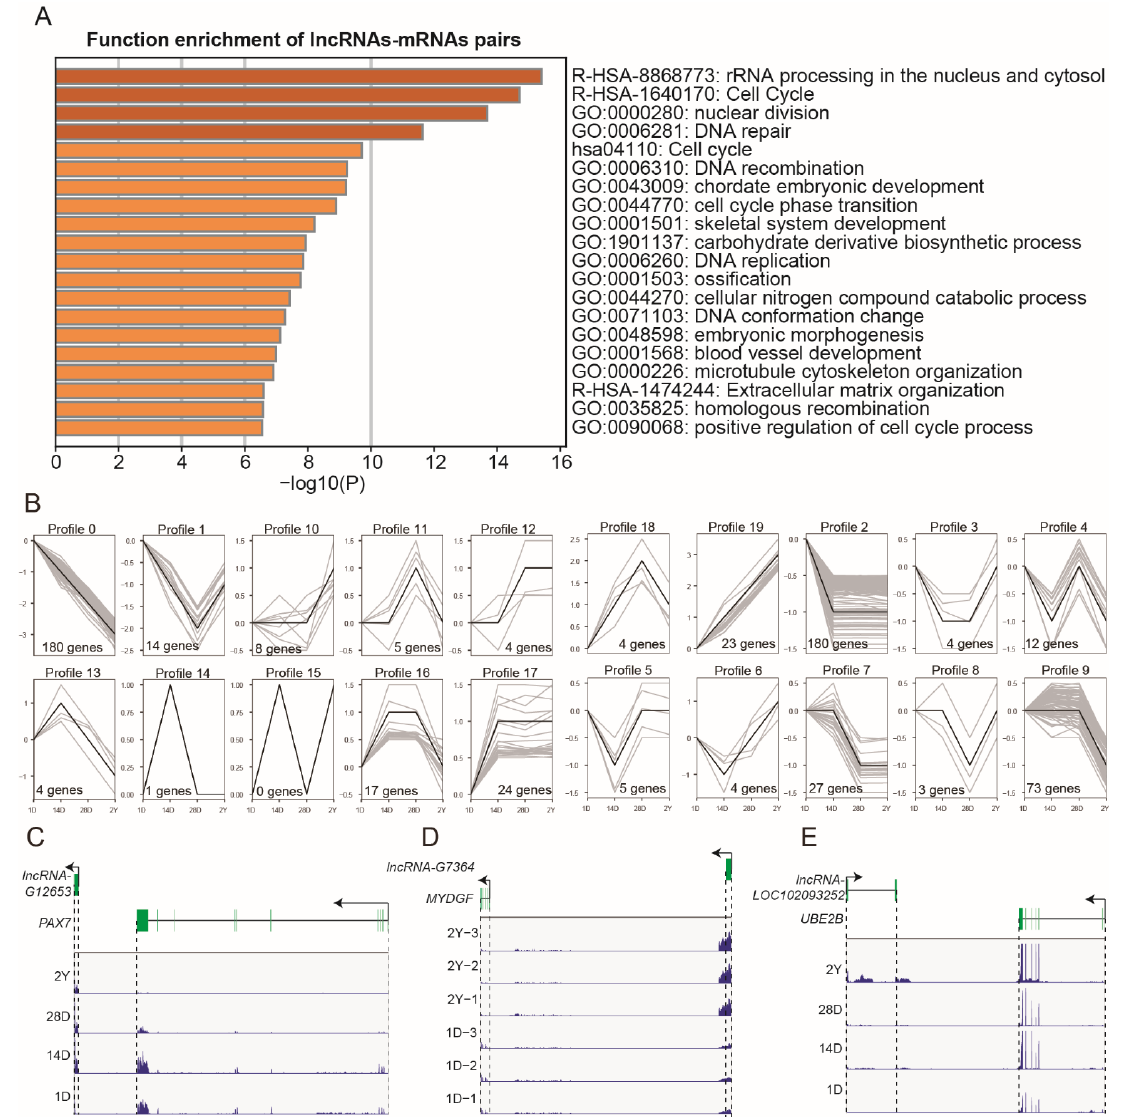
Figure 6. The trans / cis analysis of DE-lncRNAs and DE-mRNAs. ( A ) Functional enrichment analysis of DE-mRNAs that were significantly correlated and adjacent to the DE-lncRNAs. ( B ) The expres- sion trends of DE-lncRNAs that were significantly correlated and adjacent to DE-mRNAs. ( C – E ) The loci and expression levels of the representative lncRNA-mRNA pairs: G12653 and PAX7 (1D, 14D, 28D, and 2Y), G7364 and MYDGF (1D and 2Y), and LOC102093252 and UBE2B (1D, 14D, 28D, and